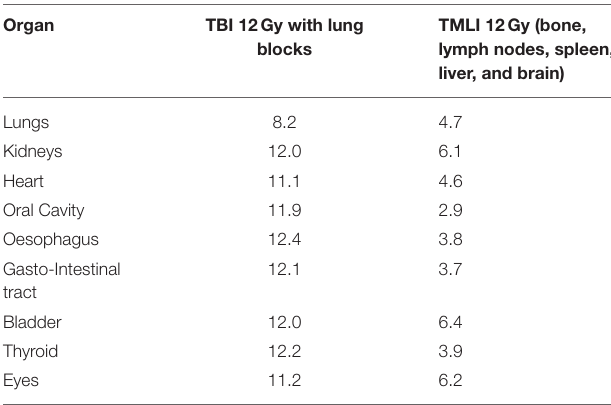
TABLE 2 | Median doses (Gy) to organs at risk for conventional TBI with lung blocks vs. TMLI in a 5 year old patient with ALL. Organ TBI 12Gy with lung TMLI 12Gy (bone, blocks lymph nodes, spleen, liver, and